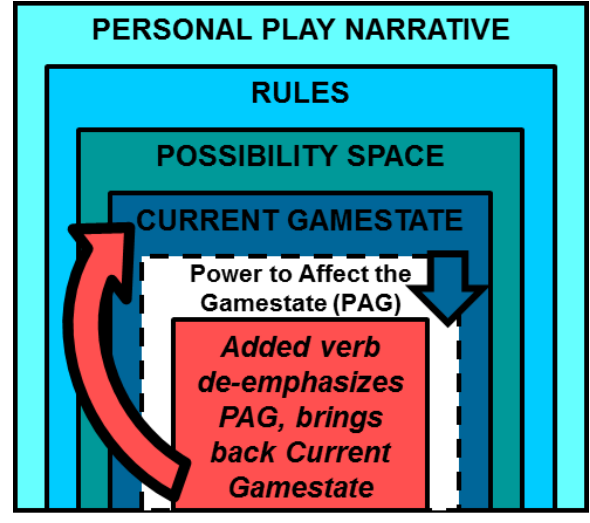
Figure 3 | Due to ‘insurance’ Current Gamestate is not